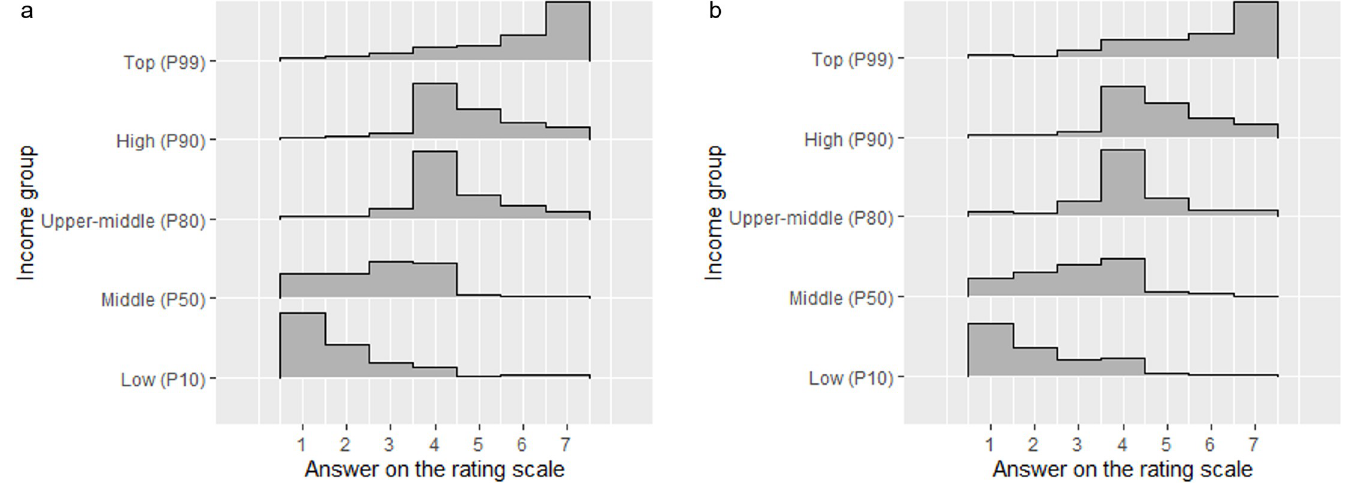
Fig 2. Distribution of the answer categories of the JEID Items for study 3 by country. Note . P = percentile. a: Germany ( N = 420). b: UK ( N = 440).